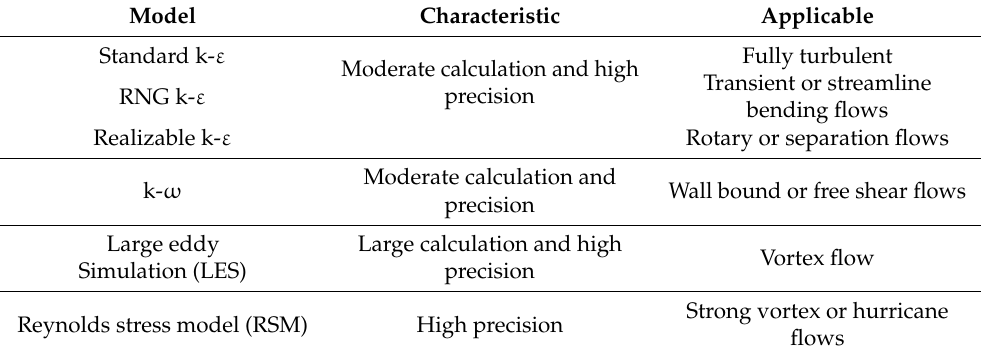
Table 1. Comparative analysis of turbulence models. Model Characteristic Applicable Standard k- ε Fully turbulent Moderate calculation and high Transient or streamline precision RNG k- ε bending flows Realizable k- ε Rotary or separation flows Moderate calculation and k- ω Wall bound or free shear flows precision Large eddy Large calculation and high Vortex flow Simulation (LES) precision Strong vortex or hurricane Reynolds stress model (RSM) High precision